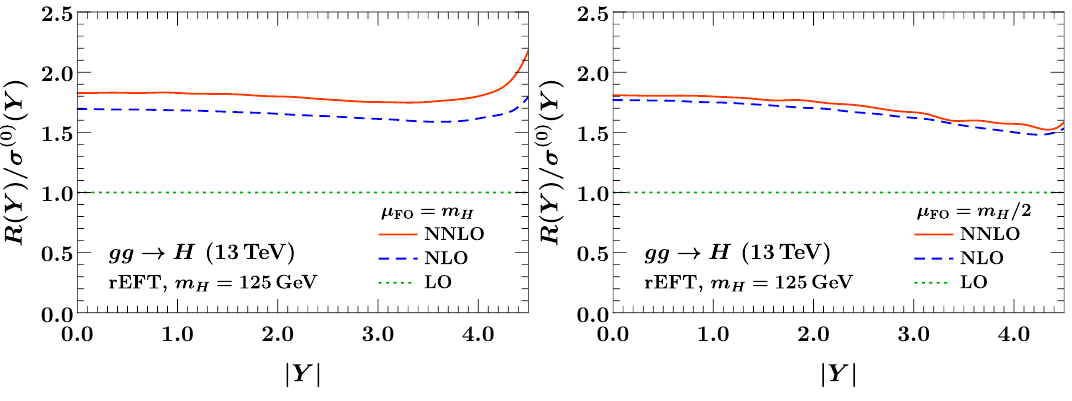
Figure 5 . The perturbative remainder R ( Y ) =(cid:27) (0) ( Y ) as a function of the Higgs rapidity Y nor- malized to the LO spectrum (cid:27) (0) ( Y ) (cid:17) d (cid:27) (0) = d Y in the rEFT limit for (cid:22) FO = m H (left) and (cid:22) FO = m H = 2